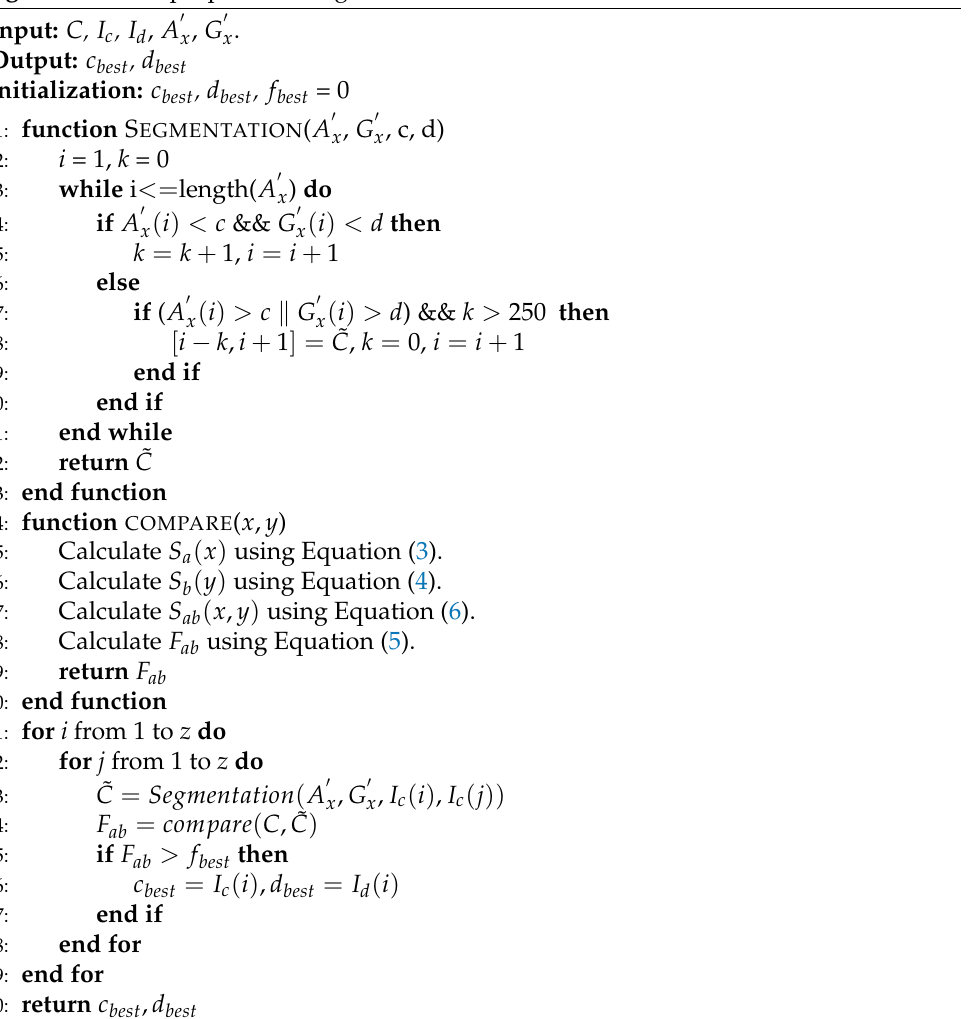
Algorithm 1 The proposed TS